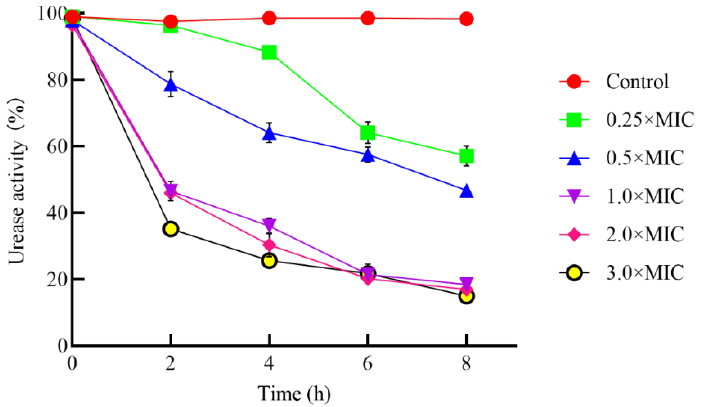
Figure 3. Urease activity of H. pylori ZJC03 co-cultured with or without different concentrations of PLNC8 for 0, 2, 4, 6, and 8 h; Control: 0.05% acetic acid buffer; Data are shown as the average ±